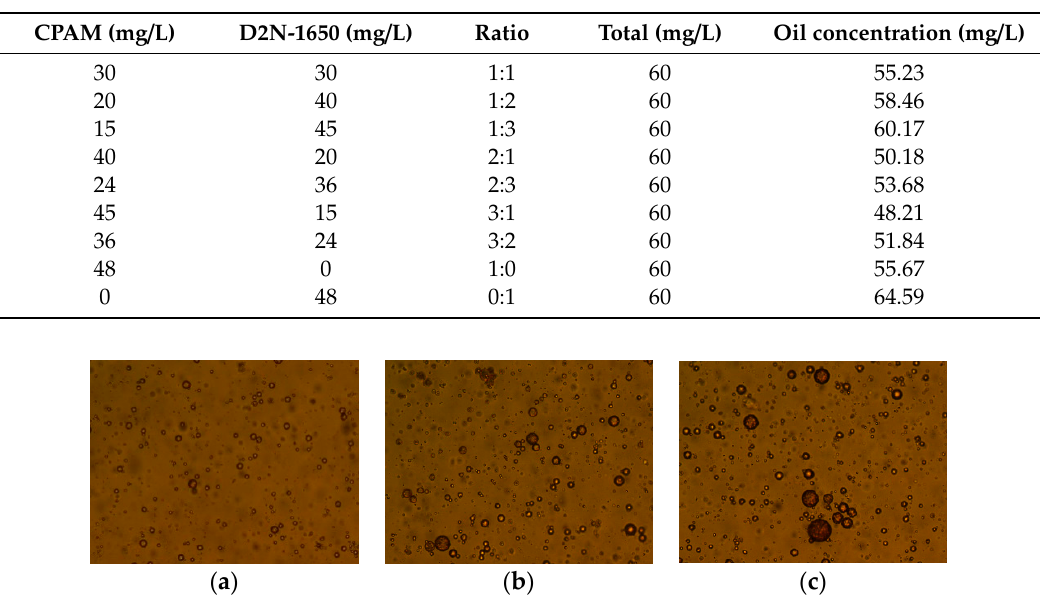
Table 5. Combination schemes and flocculation e ffi ciency of di ff erent single-agent.